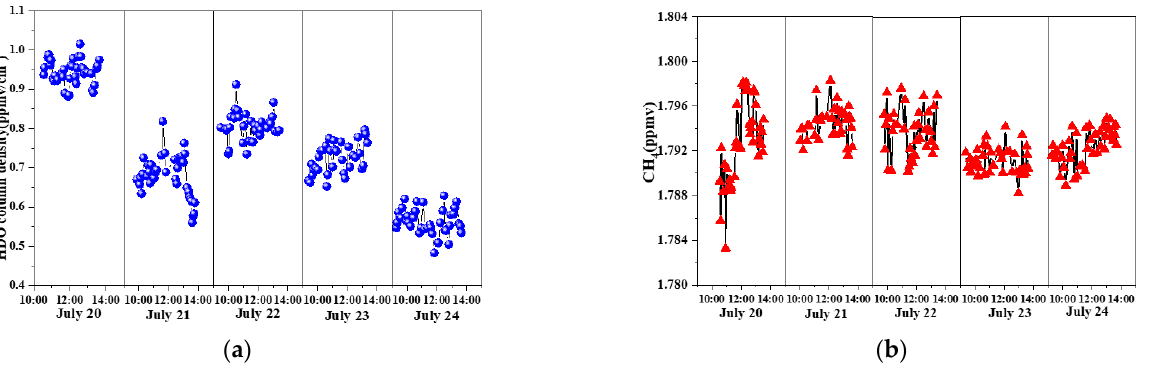
Figure 8. ( a ) HDO and ( b ) CH 4 column density from 20 to 24 July at Dunhuang. According to the HDO/H 2 O ratio of Vienna Standard Mean Ocean Water (VSMOW), the column densities of water vapor at Dunhuang are obtained and are shown in the Fig- ure 9: